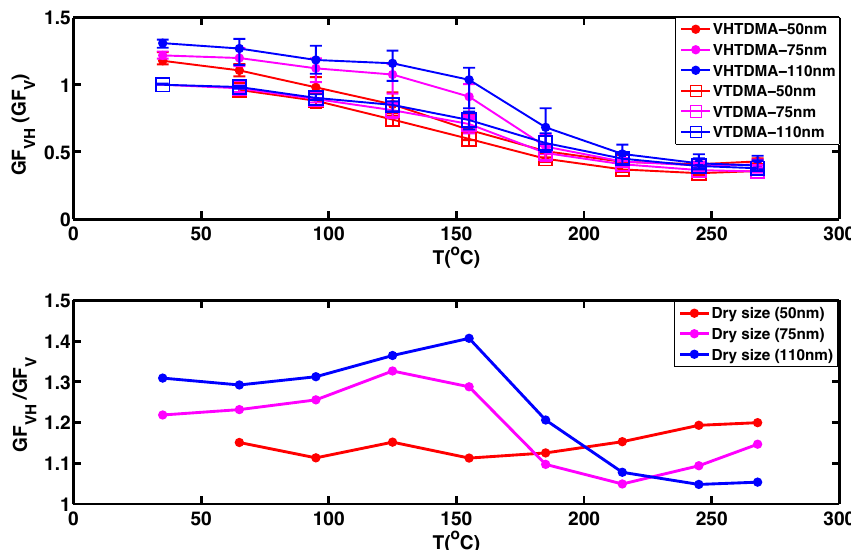
Fig. 7. GF VH with respect to the median thermodenuder temperature obtained from VH-TDMA at RH = 90%, compared with the growth factor (GF V ) from VTDMA of this study for 50nm, 75nm and 110nm particles (upper panel) and the ratio between GF VH and GF V as a function of the heating temperature (lower